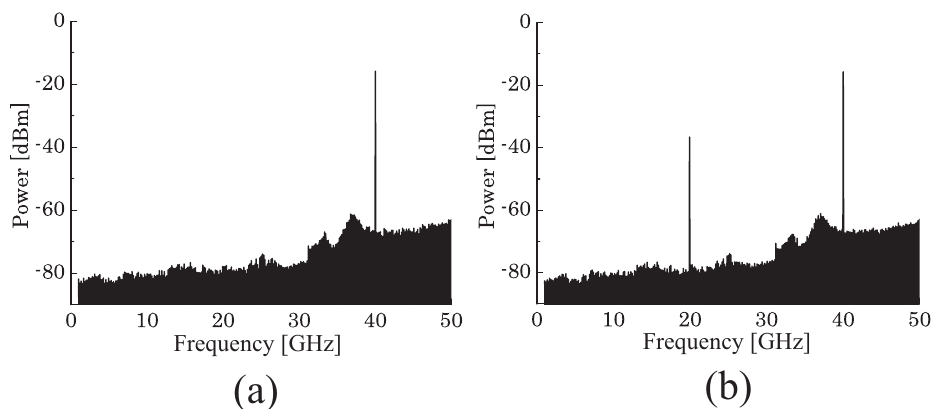
Figure 6. Spectra of RF signals generated from optical two-tone signals with compensation ( a ) and without compensation ( b ) [1].